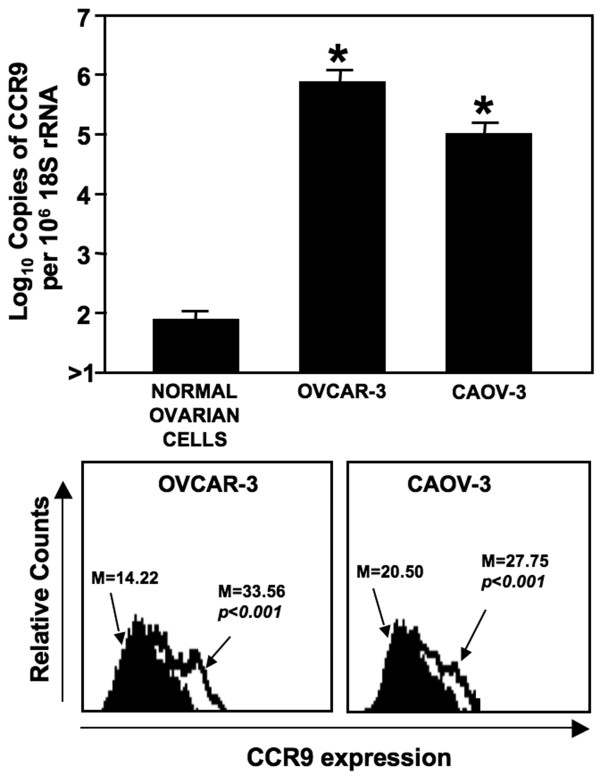
CCR9 mRNA and cell surface protein expressed by ovarian cancer cells. Total RNA was isolated from OVCAR-3 and CAOV-3 cell lines and normal primary ovary tissue. Quantitative RT-PCR analysis of CCR9 mRNA expression was performed in triplicate. The copies of transcripts are expressed relative to actual copies of 18 S rRNA ± SEM. OVCAR-3 and CAOV-3 cells were stained with PE-conjugated isotype control antibodies (solid histogram) or PE-conjugated anti-CCR9 monoclonal antibodies (open histogram) and quantified by flow cytometry. The mean fluorescent intensities of PE-positive cells are shown. Asterisk(s) indicate statistical significance (p < 0.01) between normal tissue and OvCa cells.